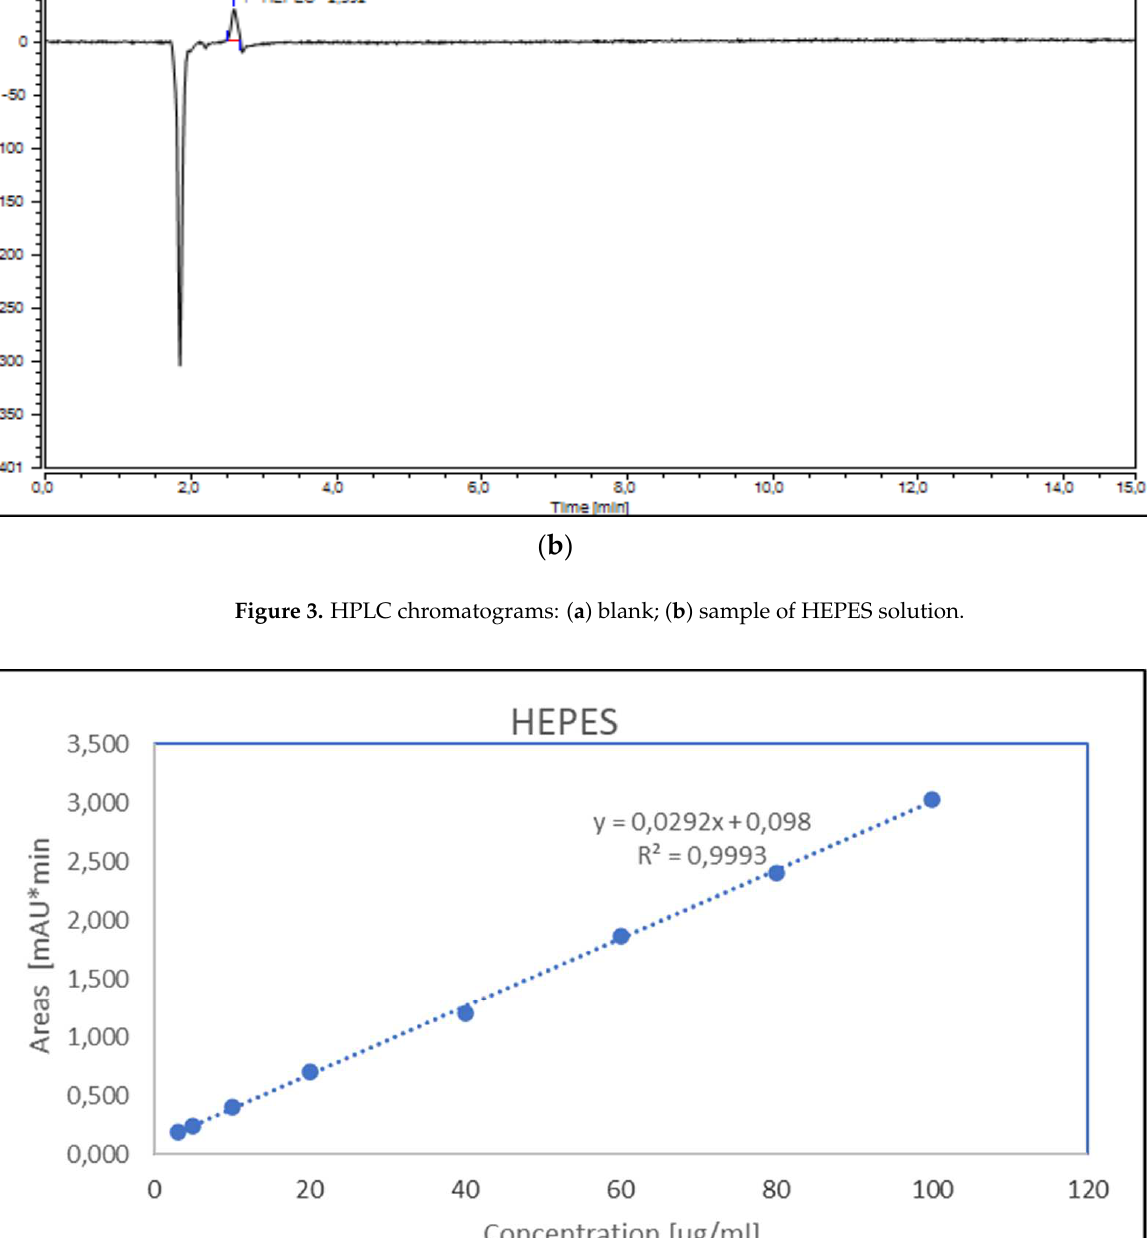
Figure 4. Calibration curve obtained with the average values of peak areas of five different concen- trations (100, 80, 60, 40, 20, 10, 5, 3 ug/mL) of HEPES.